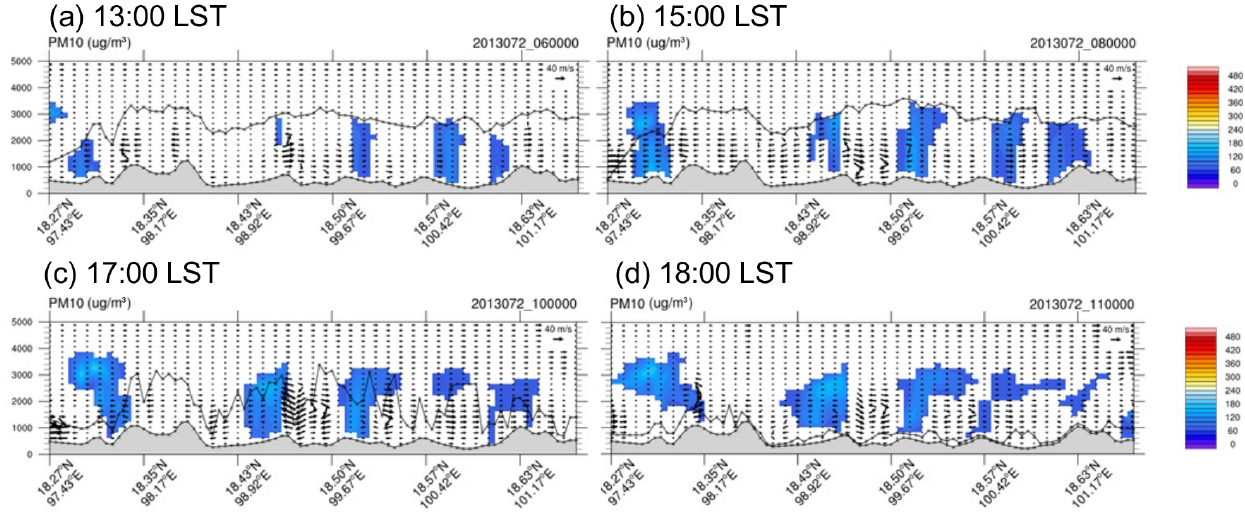
Figure 9. The modeled vertical cross-section profile (BB’ in Fig. 1c) up to 5km over nPSEA on 13 March: PM 10 concentration (contour; IWrp + EC; µgm − 3 ), horizontal wind profile (vector; ms − 1 ) in x direction and vertical wind profile in y direction (vector; cms − 1 ), boundary layer height (dotted lines; in meters), terrain